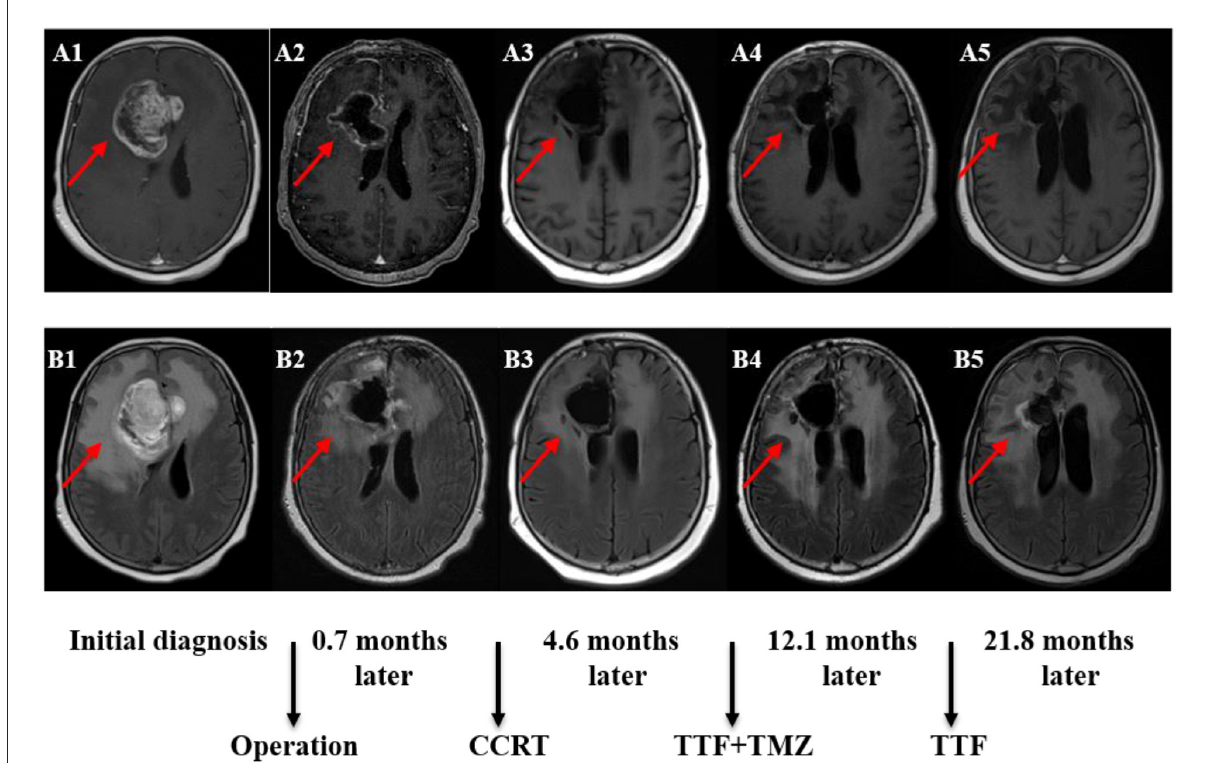
FIGURE2 MRI (Magnetic Resonance Imaging) changes of newly diagnosed glioblastoma (GBM). (A1–A5) Contrast-enhanced MRI; (B1–B5) MRI-Flair. MRI images followed-up every 2 months before and after treatment. Only some of the images were exhibited. The arrow indicates the tumor and tumor bed. This patient has followed-up for 35.4 months with a stable